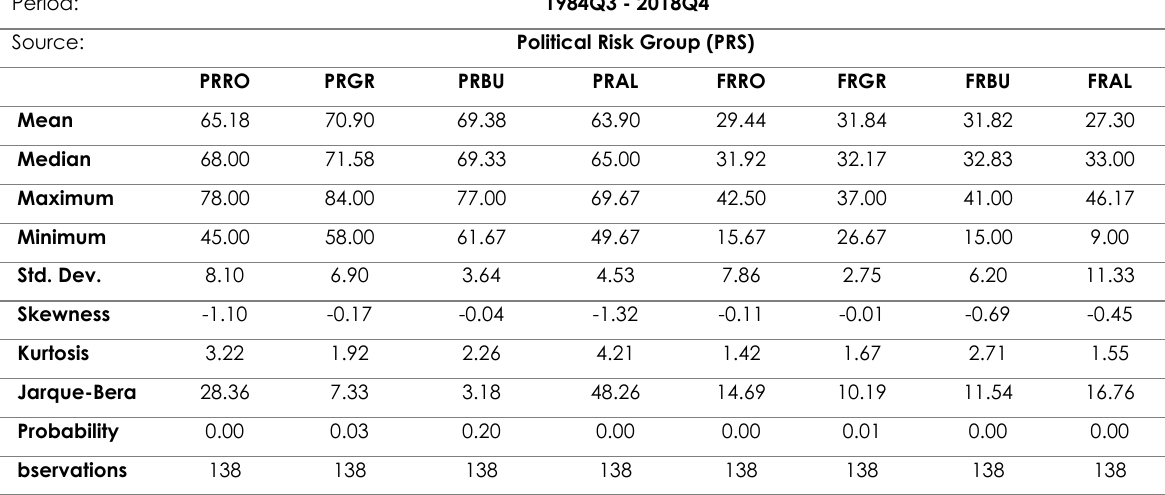
Table 1: Summary of Descriptive